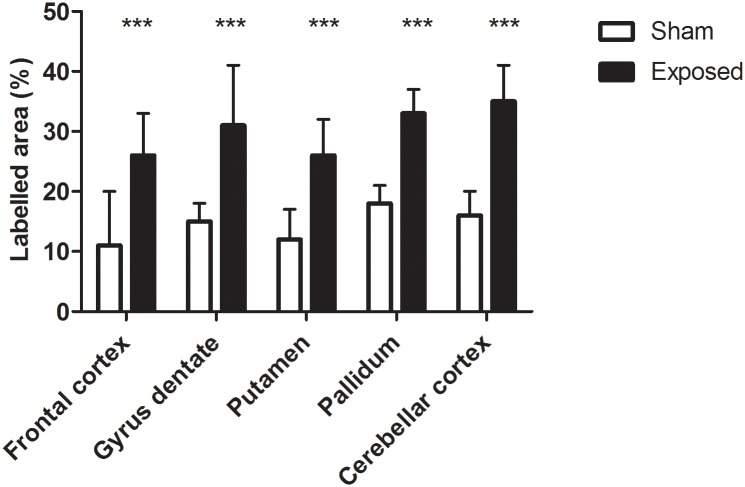
GFAP expression after repeated exposure to SRS source.GFAP immunohistochemical labelling in different brain areas two days after exposure with Superradiance S source (% labelled area—Mean ± SD). White = sham (n = 12); black = exposed (n = 12). One slice per area per animal. *** p < 0.001.